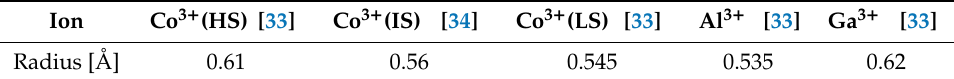
Figure 2. ( a ) XRD (CuKα) patterns of Sr 3.1 Y 0.9 Co 4− x B x O 10.5 ( B = Al and Ga: x = 0, 0.2, and 0.4) powders. ( b ) The axis lengths and the lattice volumes of Sr 3.1 Y 0.9 Co 4− x B x O 10.5 as a function of B content. Table 1. Ionic radii of high-spin (HS), intermediate-spin (IS), and low-spin (LS) states Co 3+ , Al 3+ , and Ga 3+ .